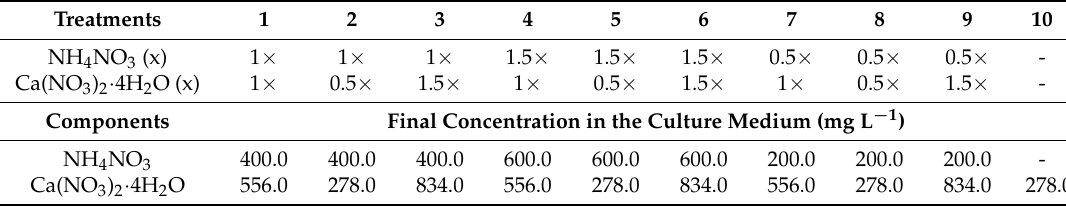
Table 3. Experiment 3 with 10 treatments. Treatments 1 to 9 with the original Woody Plant Medium (WPM) [18] with different amounts of NH 4 NO 3 (x) and Ca(NO 3 ) 2 · 4H 2 O (x) and treatment 10 with the modified WPM